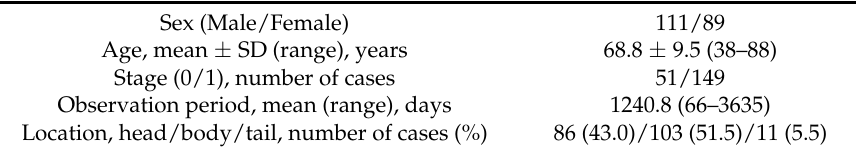
Table 2. Clinical background of patients (quoted from Reference [23]).